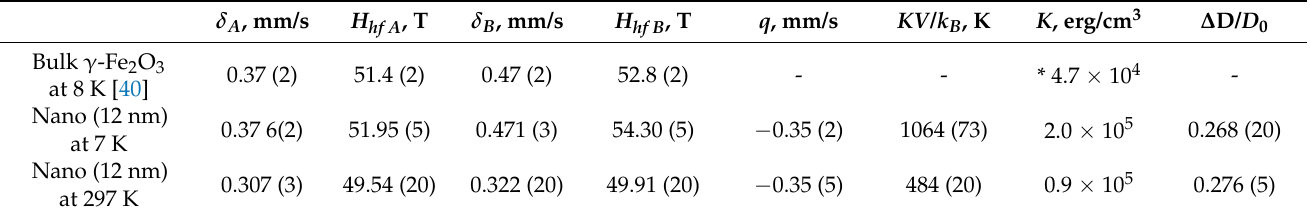
Table 1. Results of the analysis of the Mössbauer spectra of nanoparticles. δ A,B is the isomer shift for iron atoms in the (A) and [B] lattice sites; q is the quadrupole coupling constant; H hf is the hyperfine magnetic field at the 57 Fe